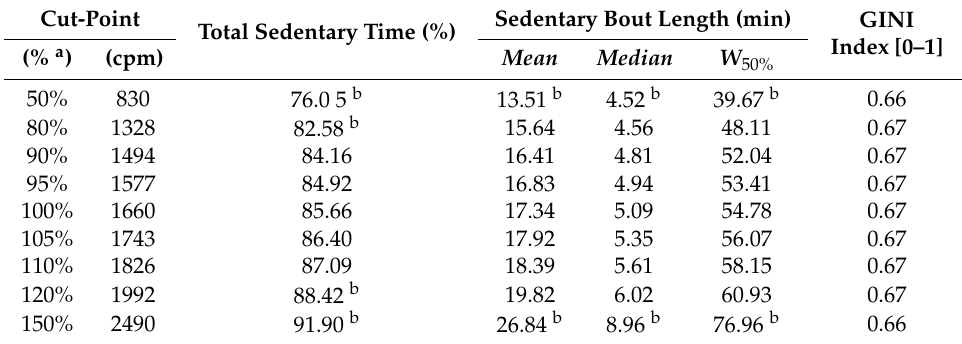
Table 1. Overview of sedentary pattern measures for various cut-points.